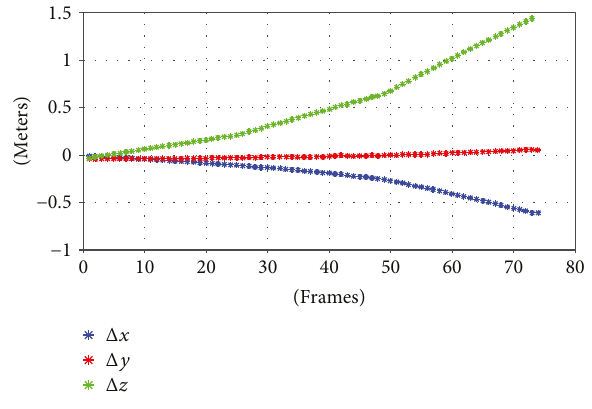
Figure 32: Data from a test point.